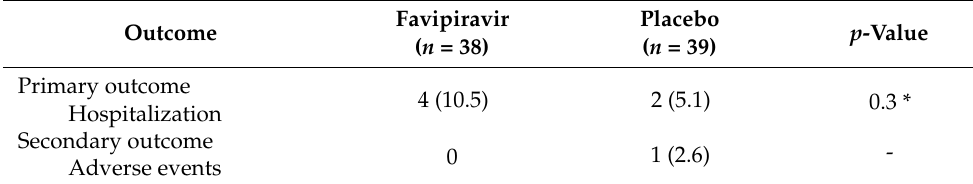
Table 2. Primary and secondary outcomes in the study groups.